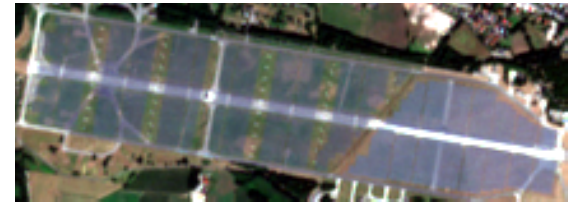
Figure 3: Sentinel-2 true color composite (bands 4, 3,